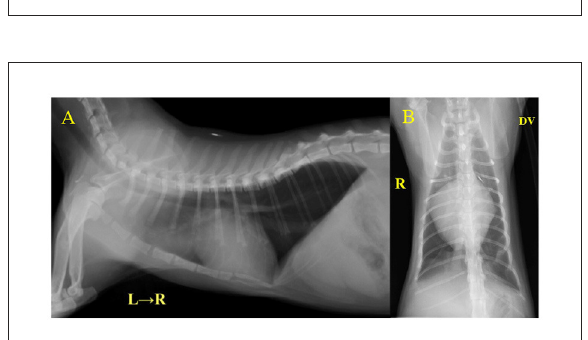
FIGURE2 Thoracic radiography at initial examination. (A) Right lateral view, (B) Dorsoventral view. The increased pulmonary opacity was observed in the bilateral anterior lobe of the lungs. VHS = 9.4v and CTR = 81% indicated a clear cardiac